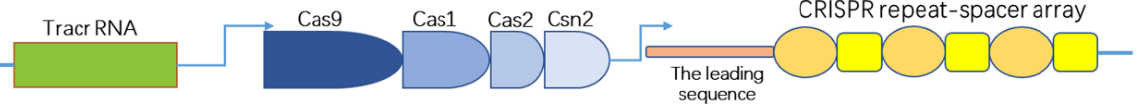
Figure 1. Basic CRISPR/Cas9 structure. The CRISPR/Cas9 locus consists of three elements, namely a tracrRNA at the 5 ′ end, a Cas protein-encoding gene, and a CRISPR locus at the 3 ′ end, which includes a lead sequence, a 23–50 bp repeat sequence, and a spacer sequence.